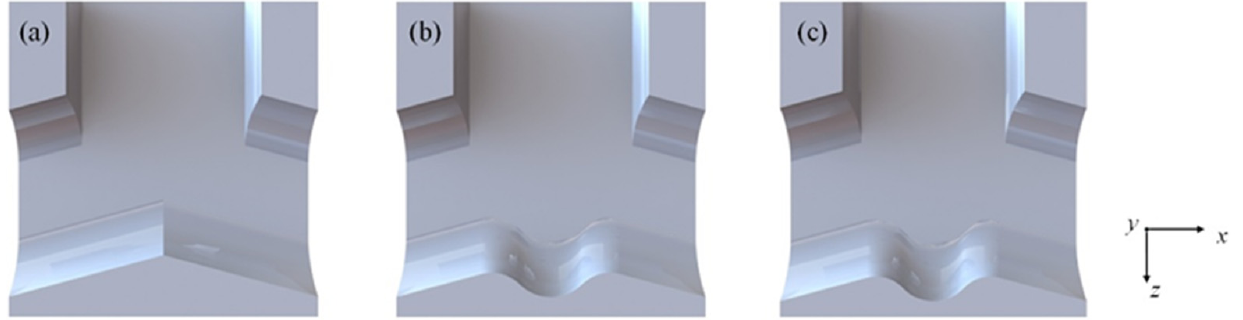
Figure 1. Three structures of SEN. ( a ) is SEN A, ( b ) is SEN B, ( c ) is SEN C.